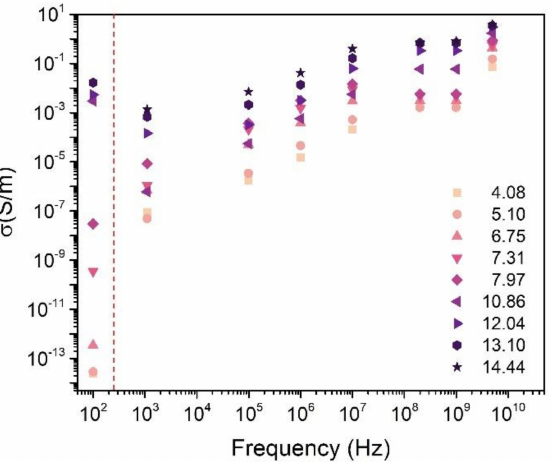
Figure 7. AC conductivity of CB composites as a function of frequency, additionally DC conductivity is